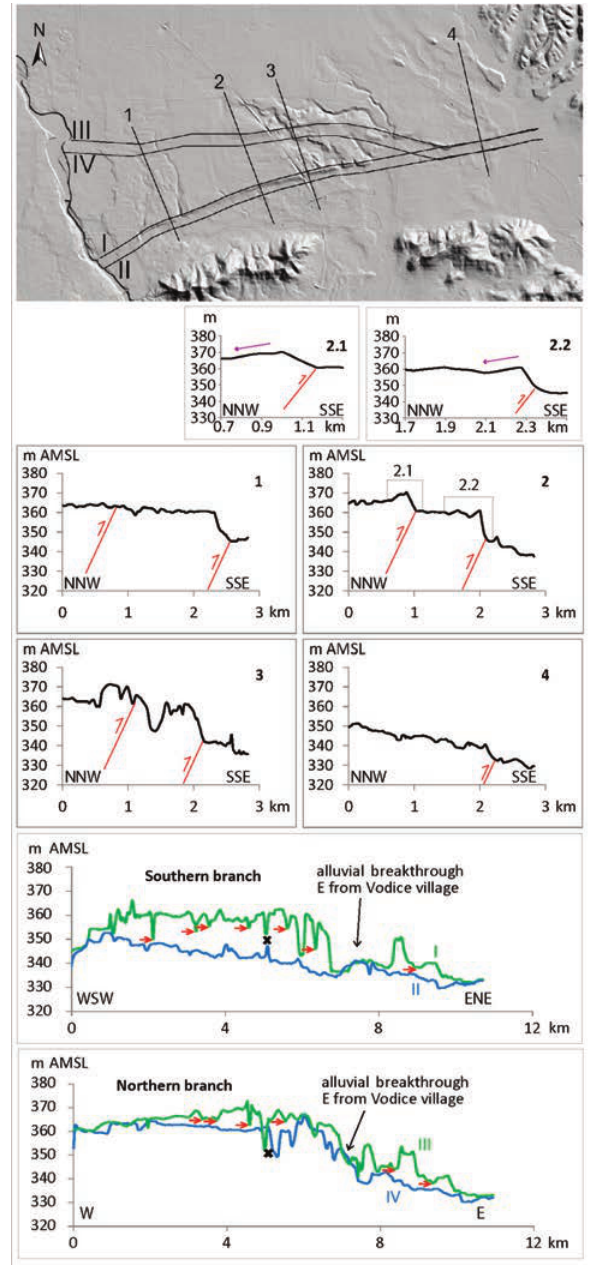
Figure 3. Series of topographic profiles extracted from DEM 5 m (Public Information of Slovenia, the Surveying and Mapping Au- thority of the Republic of Slovenia, DEM 5, 2006) across (profiles 1- 4, 2.1 and 2.2), and parallel to (profiles I-IV) the Vodice scarps. Profiles 2.1 and 2.2 show a close-up on both scarps, where north- ward sloping is indicated with purple arrows on top of the scarps. Locations of profiles 2.1 and 2.2 are indicated in the profile 2. Pro- files I and III present the scarps crest, and profiles II and IV present the scarps base. Red arrows in the profiles I and III indicate the po- sitions of perched valleys, and black crosses indicate anthropogenic excavations due to highway